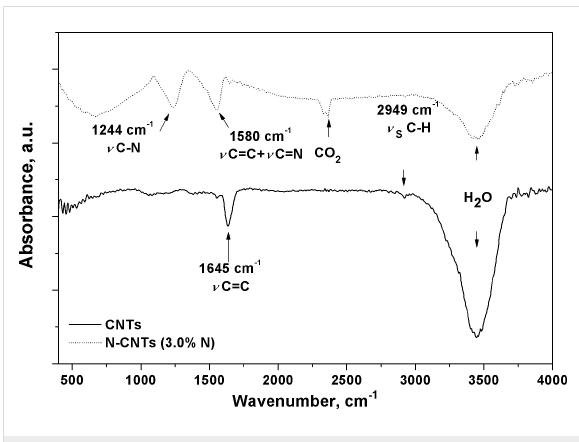
Figure 9: FT-IR spectra of CNTs and N-CNTs ( Synthesis VIII